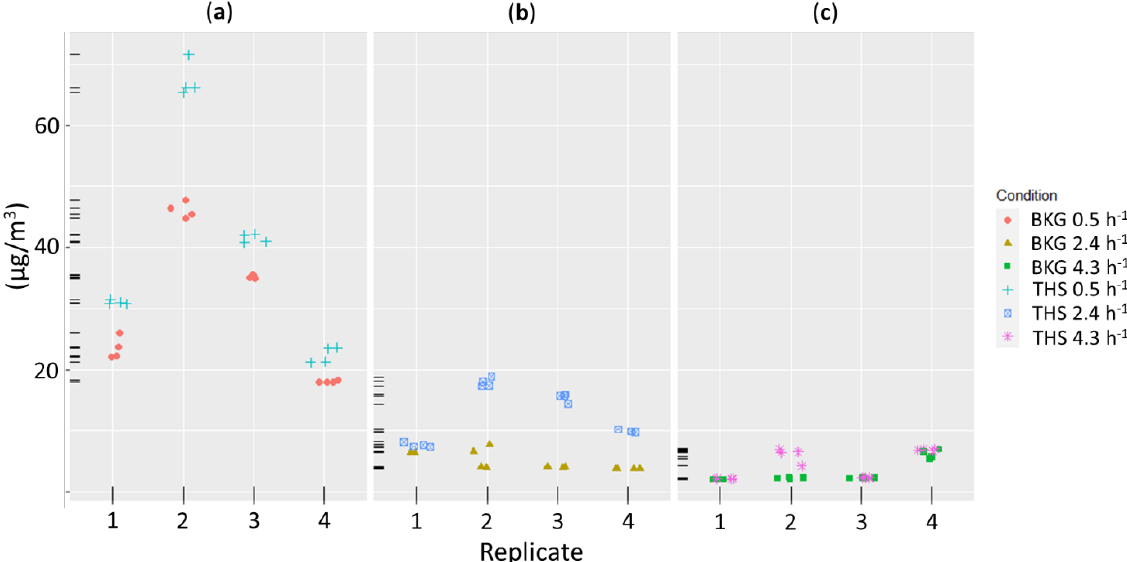
Figure 5. Comparison of the concentrations of airborne TVOCs with flavor compounds subtracted ( µ g/m 3 ) in the back- ground (BKG) and THS 2.2 use sessions (THS) under simulated ( a ) Residential category III (0.5 h − 1 ), ( b ) Store (2.4 h − 1 ), and ( c ) Restaurant (4.3 h − 1 ) environments.